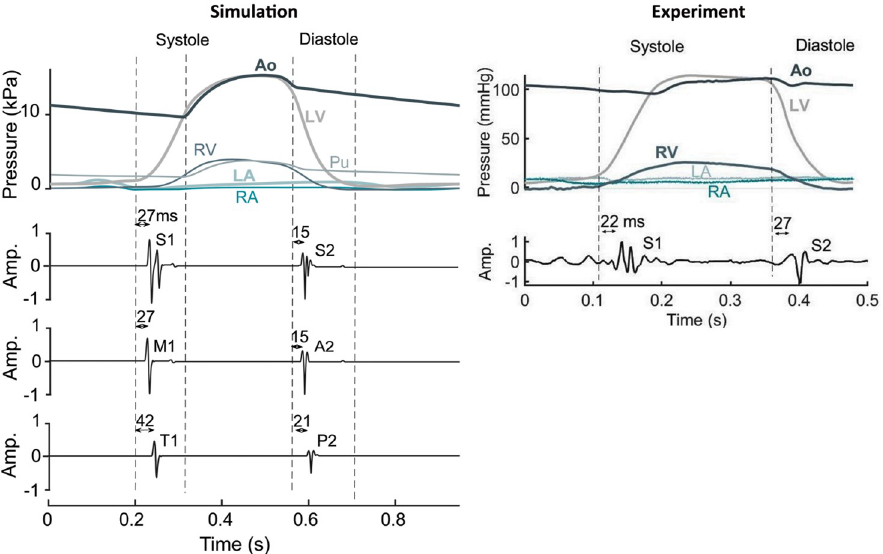
Fig 2. Heart sounds and their relationship with cardiovascular hemodynamics under resting conditions in simulation and recording on myocardium. Dashed lines indicate beginning/ending of LV isovolumic contraction/ relaxation phase. In experiment, volumetric data was used to estimate start of isovolumic phases. Since the sensor was remotely placed from the heart which caused a delay in the Ao pressure, the Ao-LV pressure cross-over could not be used as an indicator of aortic valve closure. Ao : Aorta, LA : Left atrium, LV : Left ventricle, Pu : Pulmonary artery, Ra : Right atrium, RV : Right ventricle, S1 : first component of heart sound, S2 : second component of heart sound, HS : heart sound, M1 : mitral component of first heart sound, T1 : tricuspid component of first heart sound, A2 : aortic component of second heart sound, P2 : pulmonary component of second heart sound.